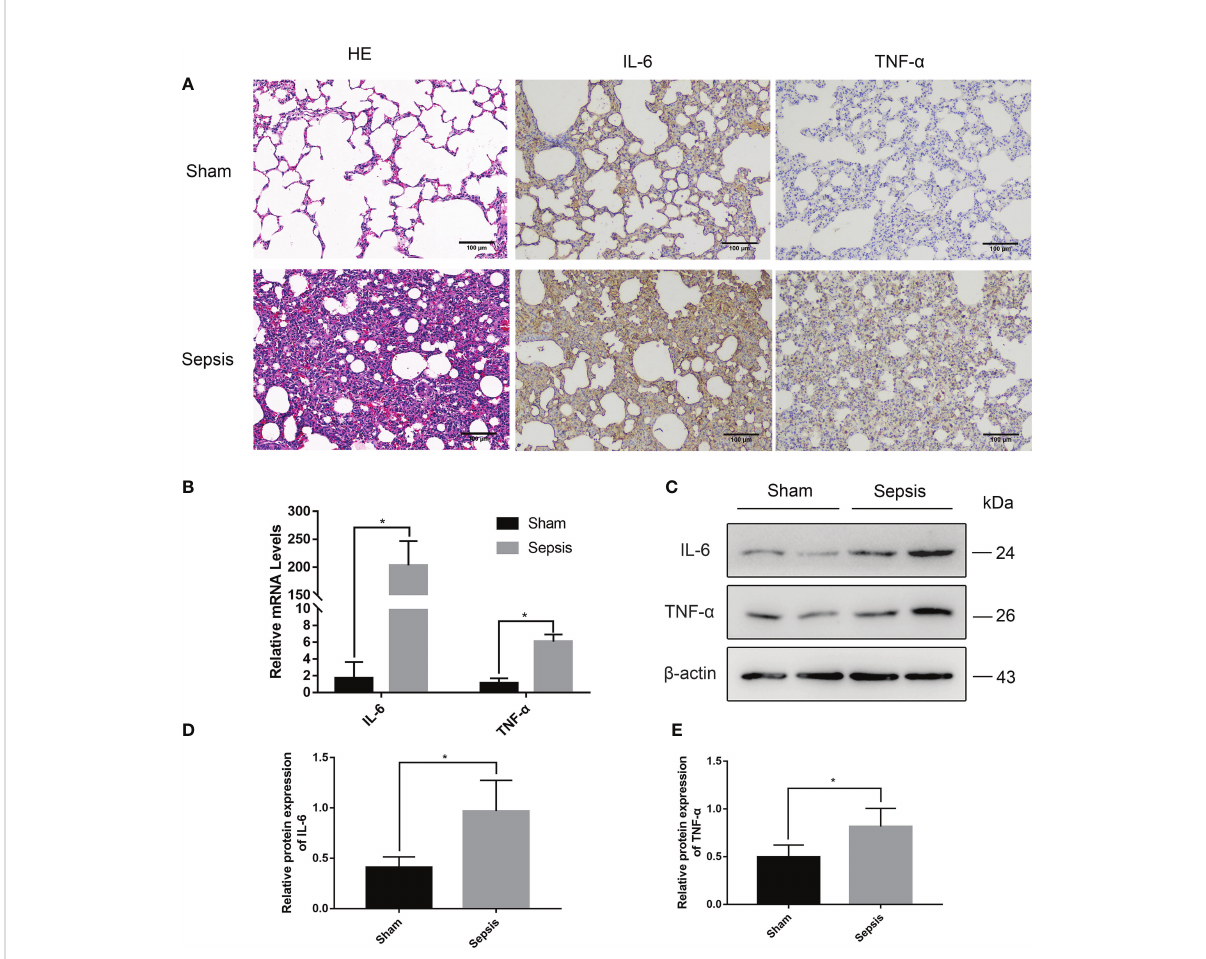
FIGURE 4 Lung injury in the rat model of urinary sepsis. (A) Representative images of hematoxylin and eosin (H&E) staining of lung tissue from the sham and sepsis groups, immunohistochemical analysis of IL-6 and TNF- a in lung tissue. (B) The relative mRNA levels of IL-6 and TNF- a in the lung tissue. (C) Expressions of IL-6 and TNF- a in lung tissue were tested by western blot, and b -actin was used as a loading control. (D, E) Quantitative data of the levels of IL-6 and TNF- a . The sep 6× group was selected as a representative of the sepsis groups. Values were shown as mean±SD. *P < 0.05, vs sham